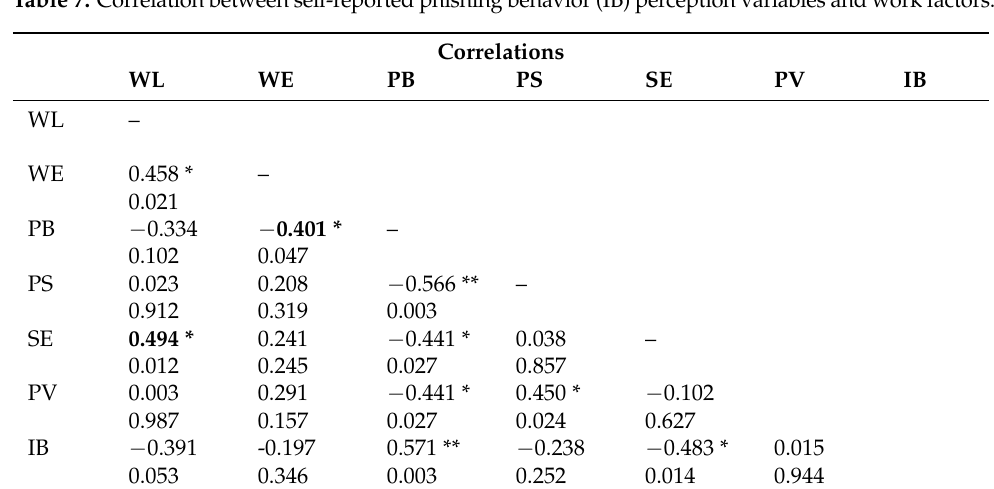
Figure 8. Research model with estimations. ** Correlation is significant at the 0.01 level (two-tailed). Table 7. Correlation between self-reported phishing behavior (IB) perception variables and work